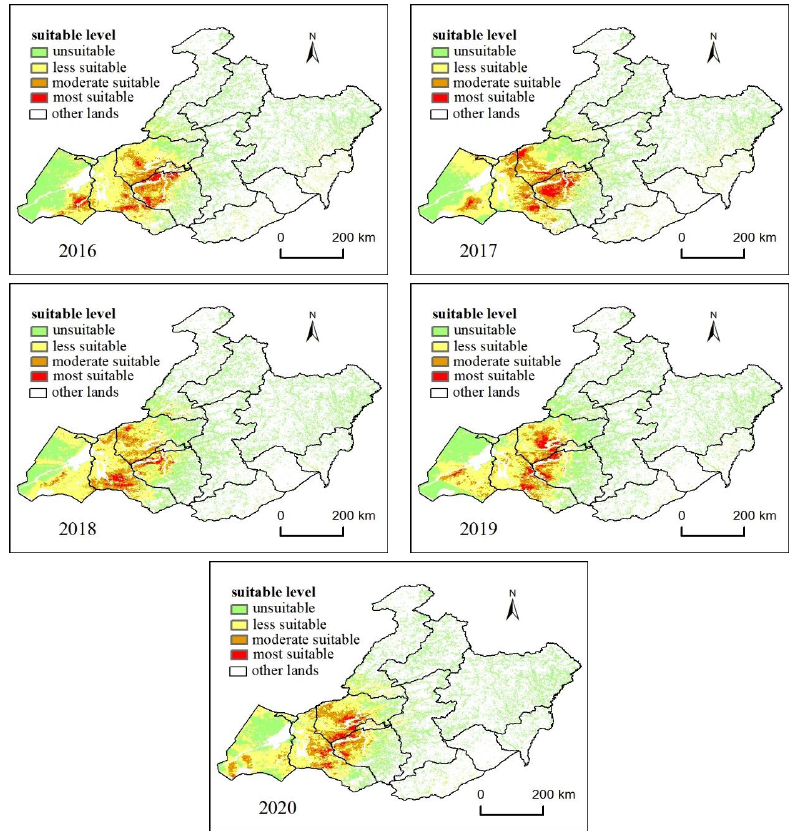
Figure 4. Spatial distribution of suitable areas for grasshoppers in Hulunbuir grassland from 2008 to 2020.